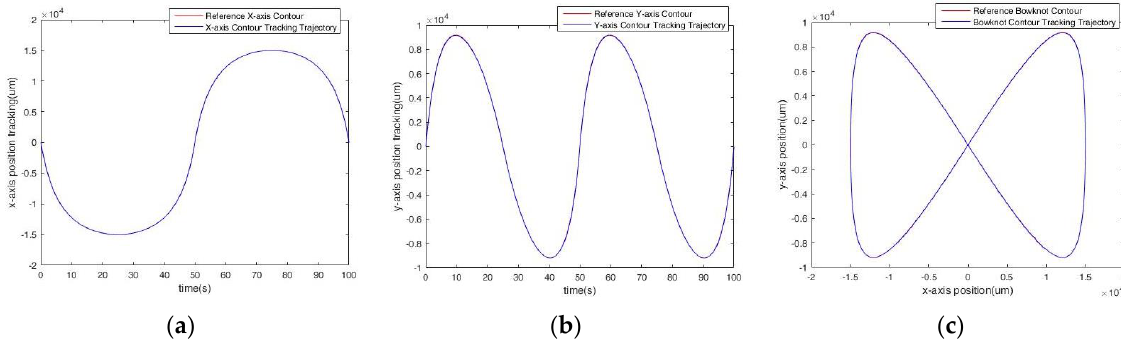
Figure 11. The path trajectory of the experiments. ( a ) The X-axis tracking response, ( b ) the Y-axis tracking response, ( c ) the circle path response.